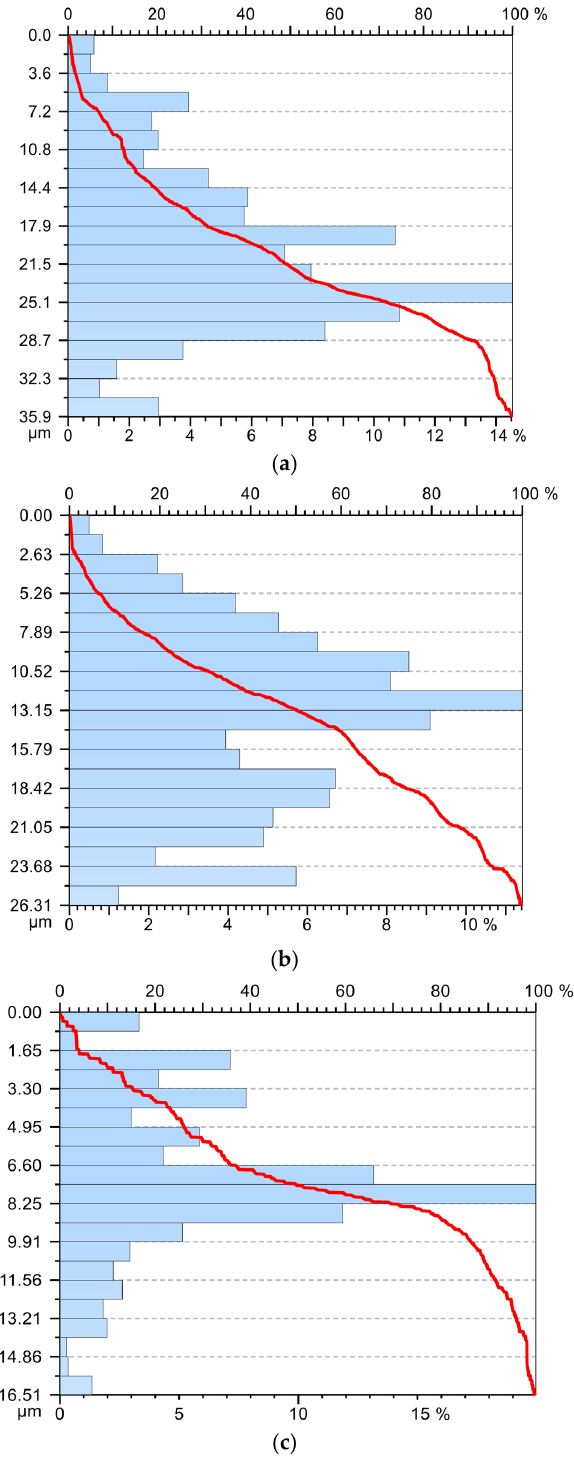
Figure 10. Abbott Firestone curve: ( a )—in the case of machining with a V01 cutting tool; ( b )—in case of machining with V02 cutting tool; ( c )—in case of machining with cutting tool V03.